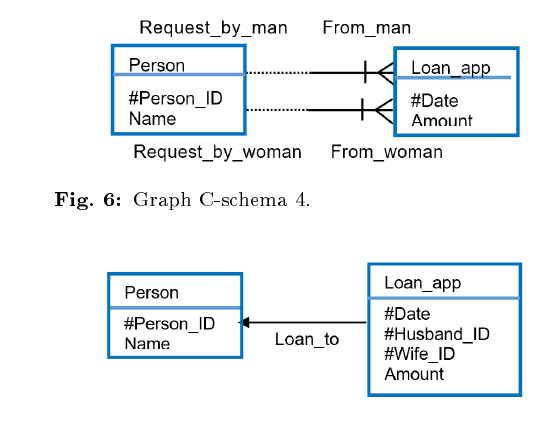
Fig. 7: Graph DB-schema